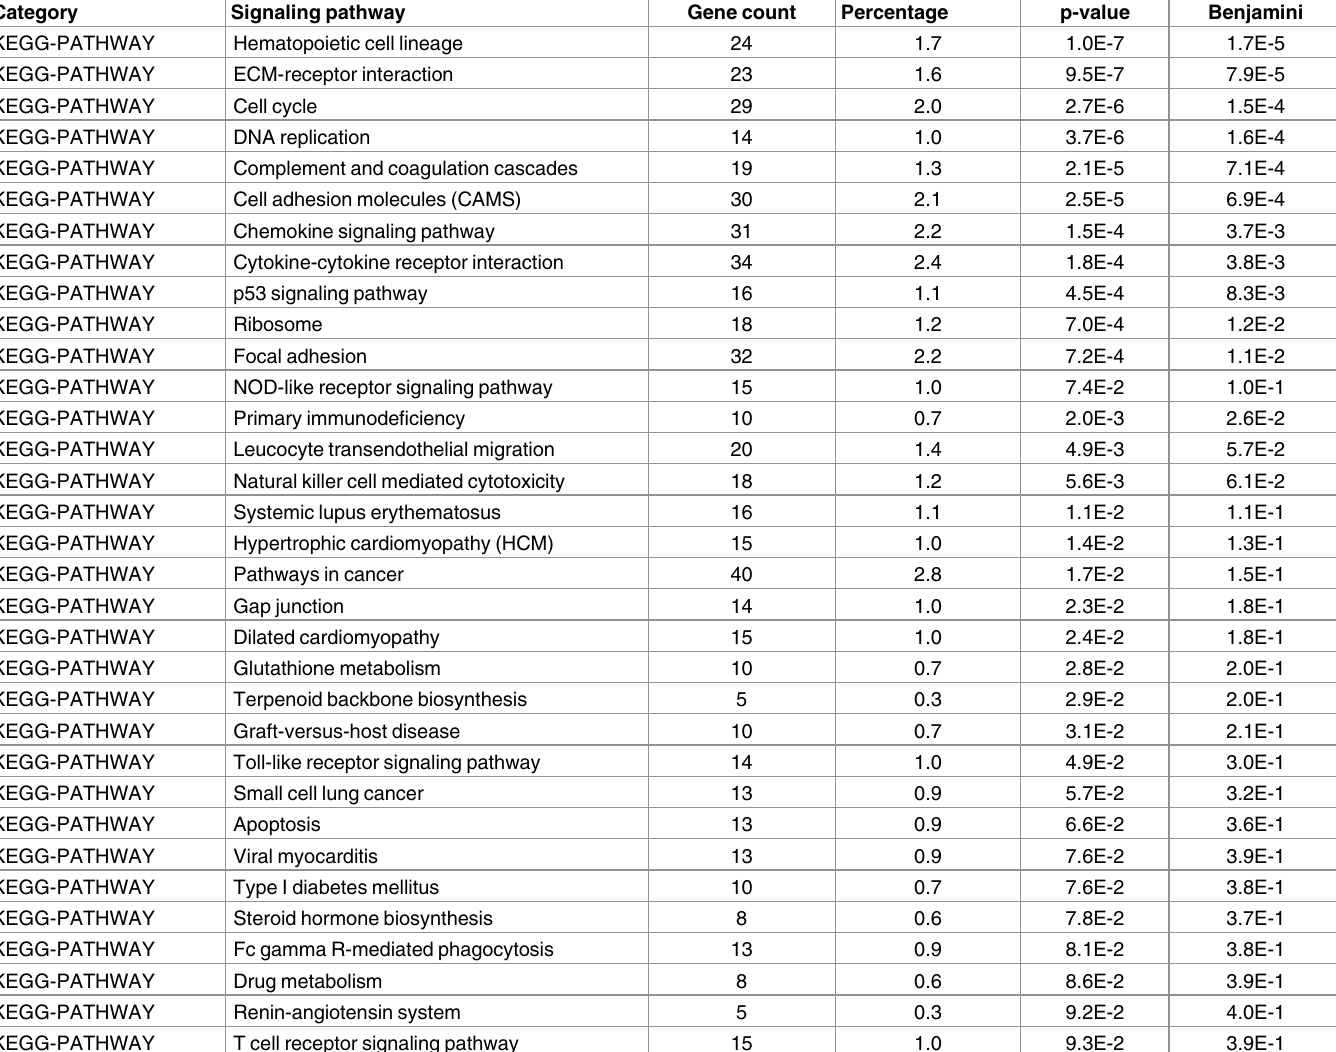
Table 2. Functional annotation charts showing differentially expressedpathways of highly expressedgenes in the EG group on Day 28. Category